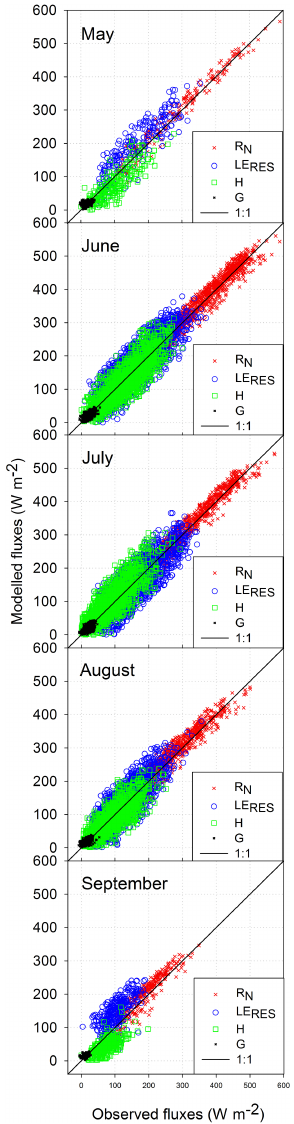
Figure 5. Comparison of modeled vs. observed half-hourly surface fluxes (using LE from residual closure) by month using α PTC of 0.92 and G estimated by the new model. The 1:1 line represents perfect agreement with